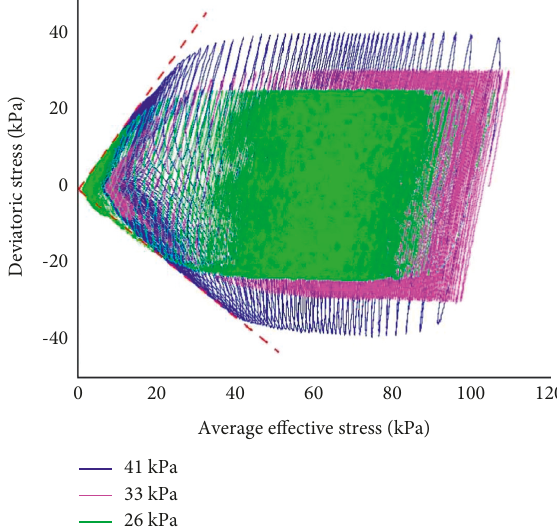
Figure 5: Time history curve of effective pore water pressure of standard sand.